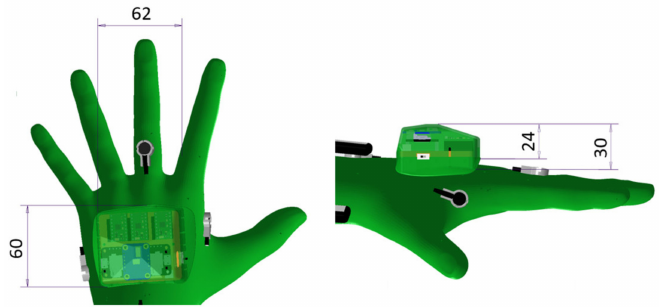
Figure 2. HMI hardware design - main dimensions.